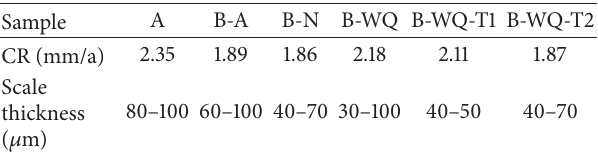
Table 3: Average corrosion rates (CR) from weight loss measure- ment and scale